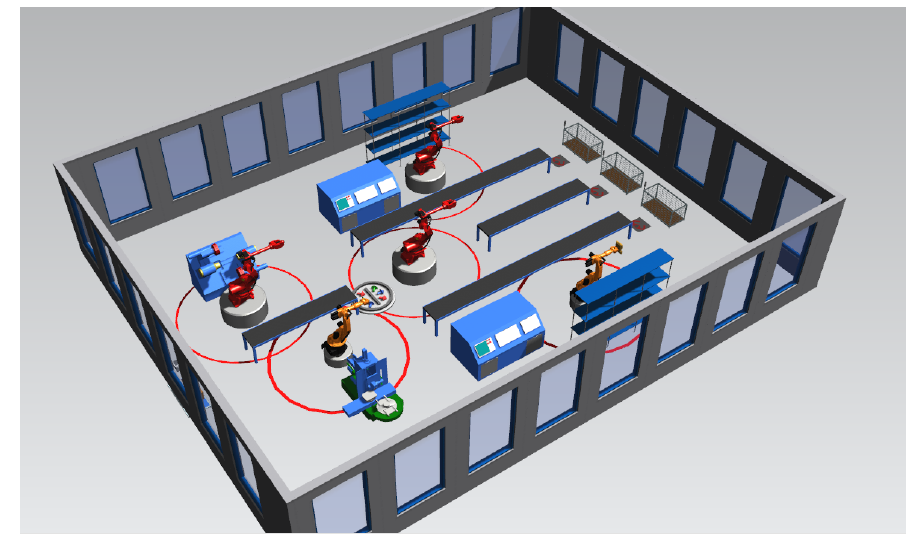
Figure 15. Possible architecture for small and medium enterprises consists of storages, cognitive robots, hybrid control, CNC machines, and laser quality